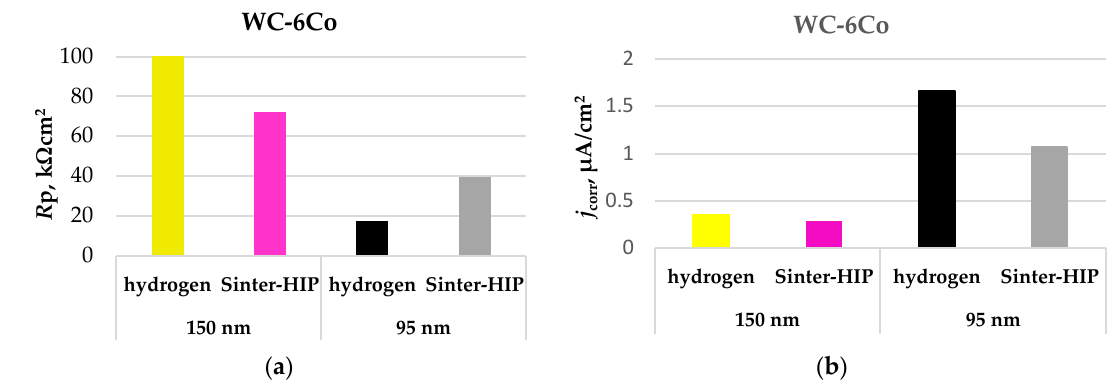
Figure 5. Correlation of electrochemical parameters and WC powder size for WC-6Co. ( a ) Correlation of polarisation resistance and WC powder size; ( b ) Correlation of corrosion current density and WC powder size.